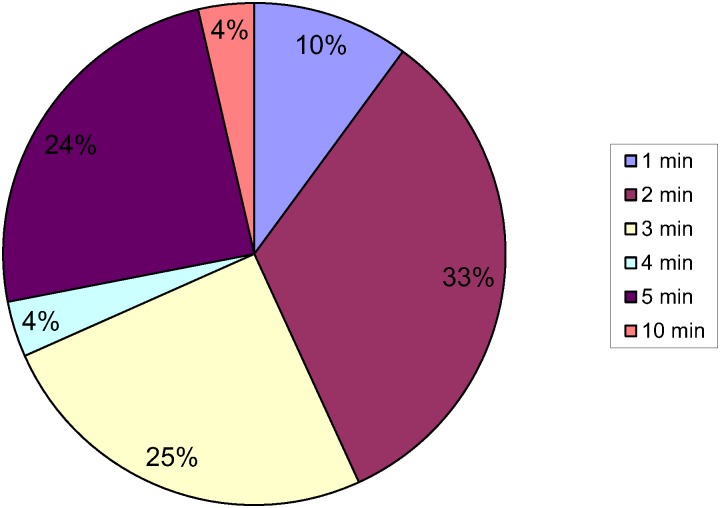
Centrifugation time.